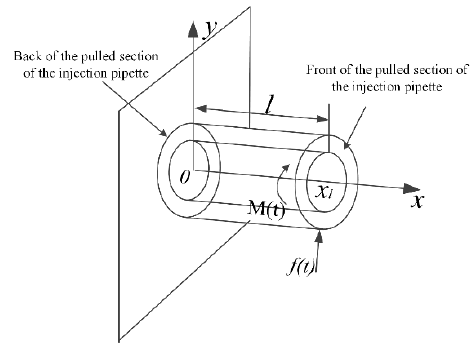
Figure 3. Schematic of the pulled section of the injection pipette.